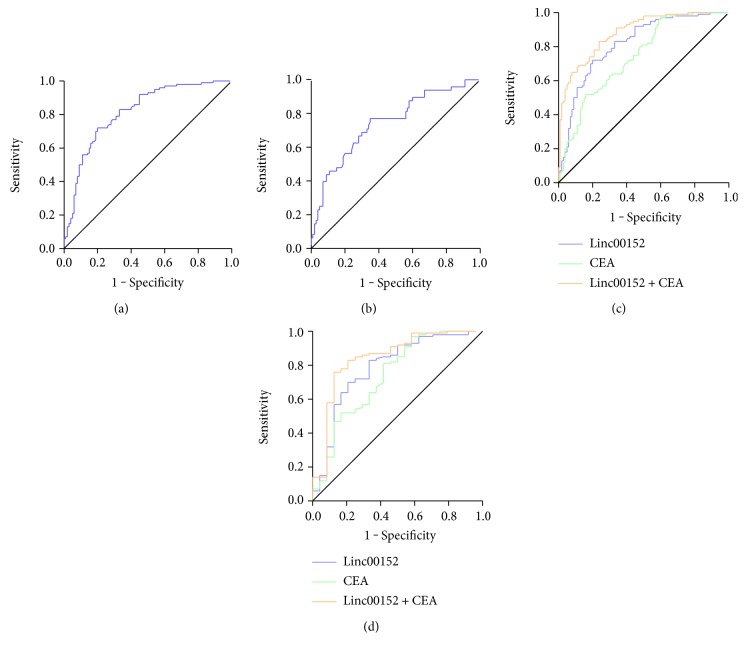
(a-b) ROC curve for distinguishing NSCLC patients from healthy controls (a) or benign lung disease patients (b). (c-d) ROC curves to compare the diagnostic performance of Linc00152, CEA, and a combination of Linc00152 and CEA to discriminate all NSCLC patients (c) or early stage NSCLC patients (d) from healthy controls.